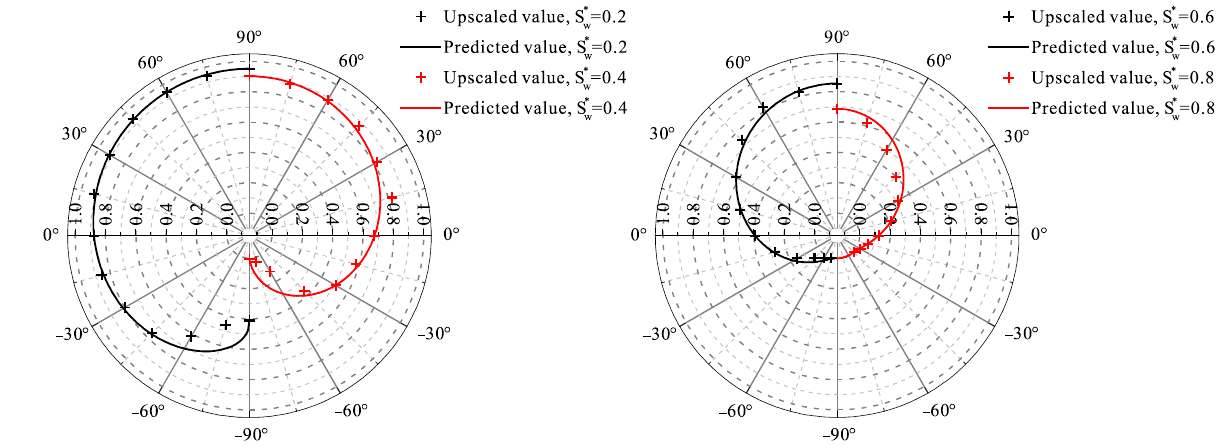
Figure 21. Comparison of oil phase relative permeability of the single-vug model obtained via the upscaling method and predicted by the proposed directional relative permeability model.